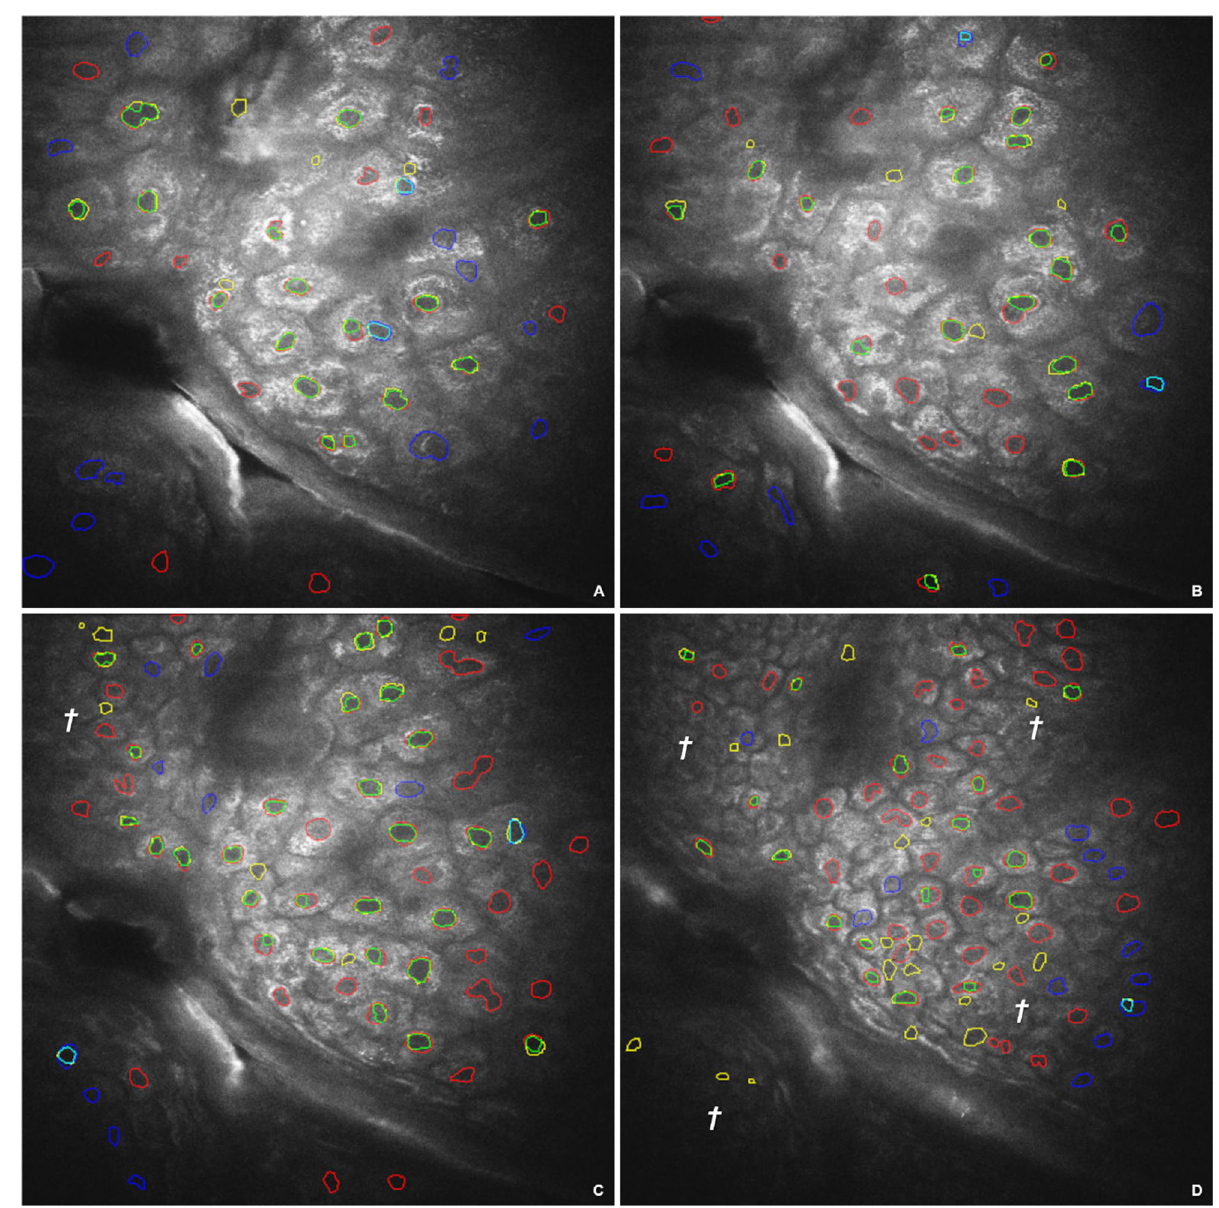
Figure 8. Ground truth comparison. Ground truth (GT) and automatic segmentation using multi-stage merging and relative quality threshold 0.97 on original input image of Slice 30 ( A ), 33 ( B ), 37 ( C ), and 45 ( D ). Red contours correspond to the certain nuclei of GT, blue contours correspond to the uncertain ones, green contours correspond to the segmented regions that coincide with the certain GT segments, cyan contours correspond to the segmented uncertain GT contours, and yellow outlines are false positives. † marks peripheral areas with ambiguous cell